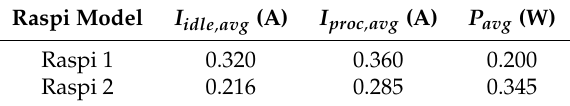
Table 1. Average power for the Raspi